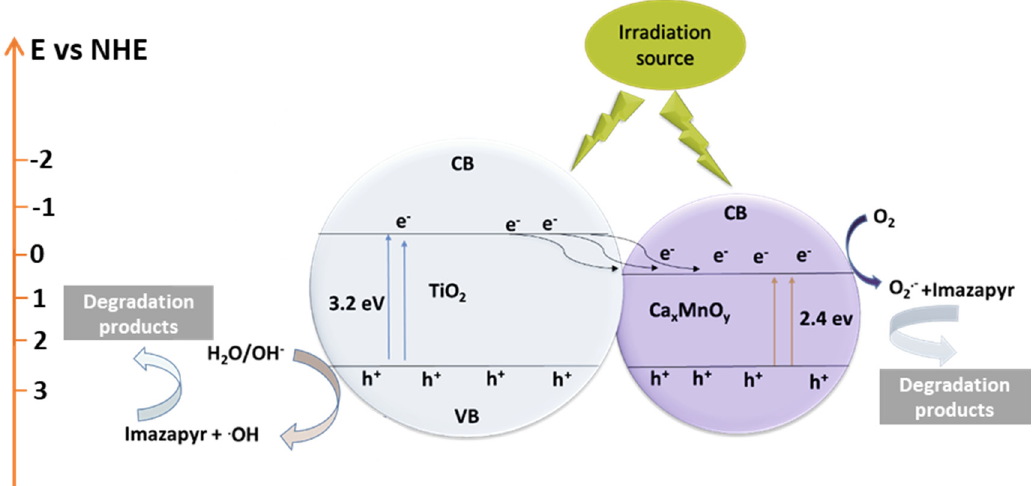
Figure 20. Band scheme for the enhancement in the photocatalytic activity of TiO 2 by Ca x MnO y